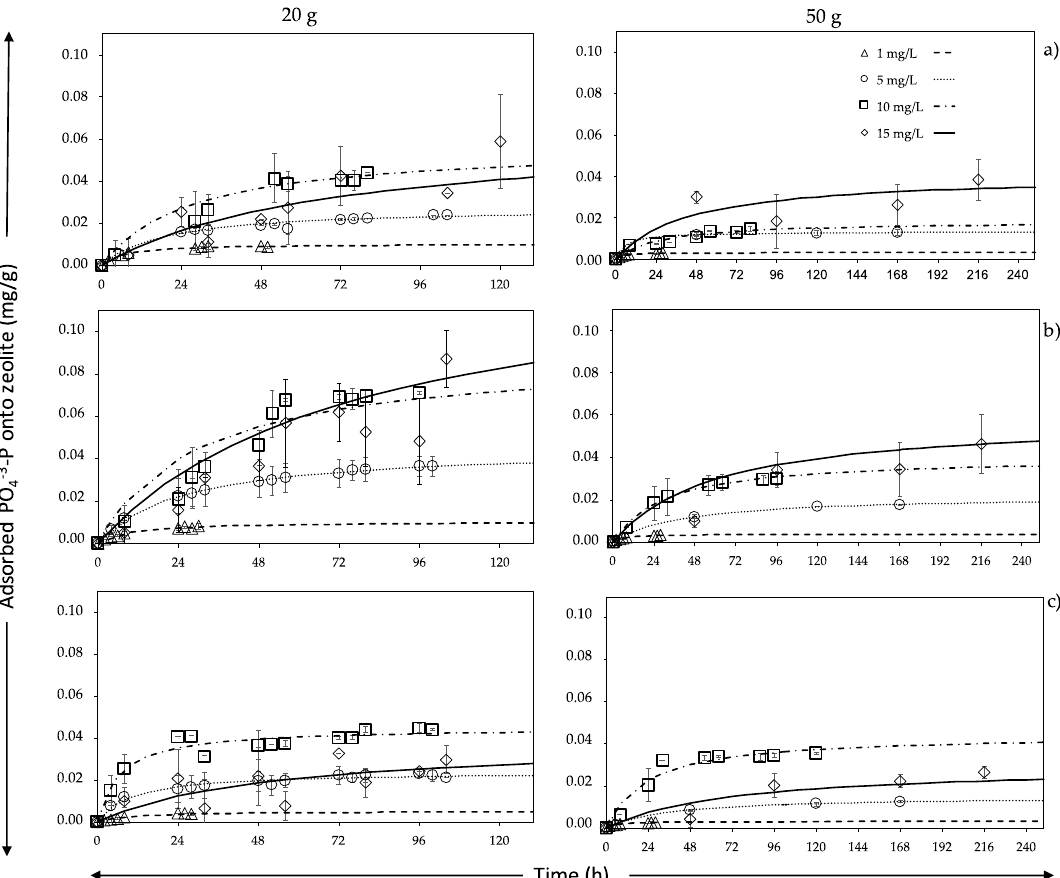
Figure 2. Adsorbed phosphate (mg / g) onto zeolite vs. time in batch assays for the determination of adsorption characteristics. Particle size: ( a ) 5.0–8.0 mm; ( b ) 1.5–3.0 mm; and ( c ) 0.2–1.0 mm.